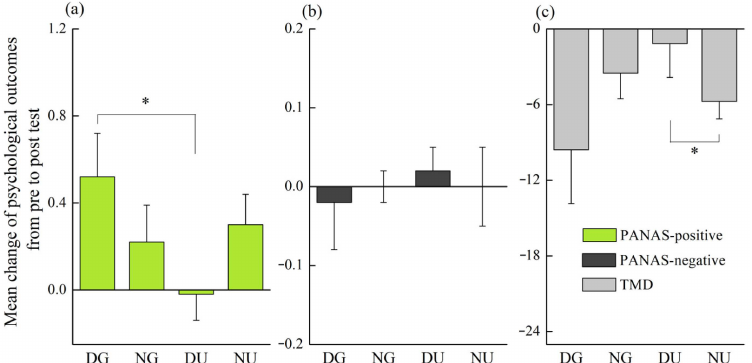
Figure 6. The psychological changes of walking in different scenarios. The ( a ), ( b ), and ( c ) represent changes in scores of PANAS-positive, PANAS-negative, and POMS-TMD respectively. The DG, NG, DU, and NU represent daytime green walking, nighttime green walking, daytime urban walking, and nighttime urban walking respectively. The error bar represents standard error, and * represents p < 0.05. Analyzed using the Kruskal–Wallis test ( N = 12). The proportions of participants who exhibited positive responses were also calcu- lated to reveal the difference among different walking scenarios. However, no statistically significant difference was found among the scenarios (Table 5). Table 5. Proportions of participants with positive responses in psychological parameters after walking in different scenarios.